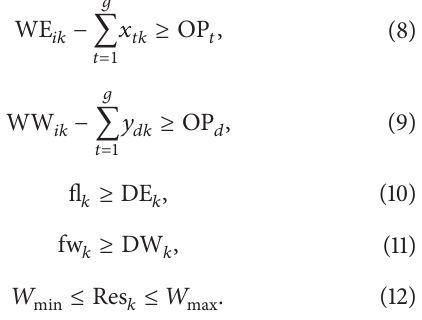
in each chromosome are swapped. This produces the children (offspring) shown in Figure 7. The size of the selected neigh- borhood NB varies but does not exceed 50% of the length of the chromosome. As an example of neighborhood size, in Figure 7 the size of neighborhood is 40%, 4 genes out of 10 the length of chromosome. With the 4-point crossover four crossover positions are selected at random and the value of genes exchanged between the chromosomes along with these points. Then two new offspring are produced. The length between two selected points is not fixed, where it could bind only one gene, or it could be segment as in Figure